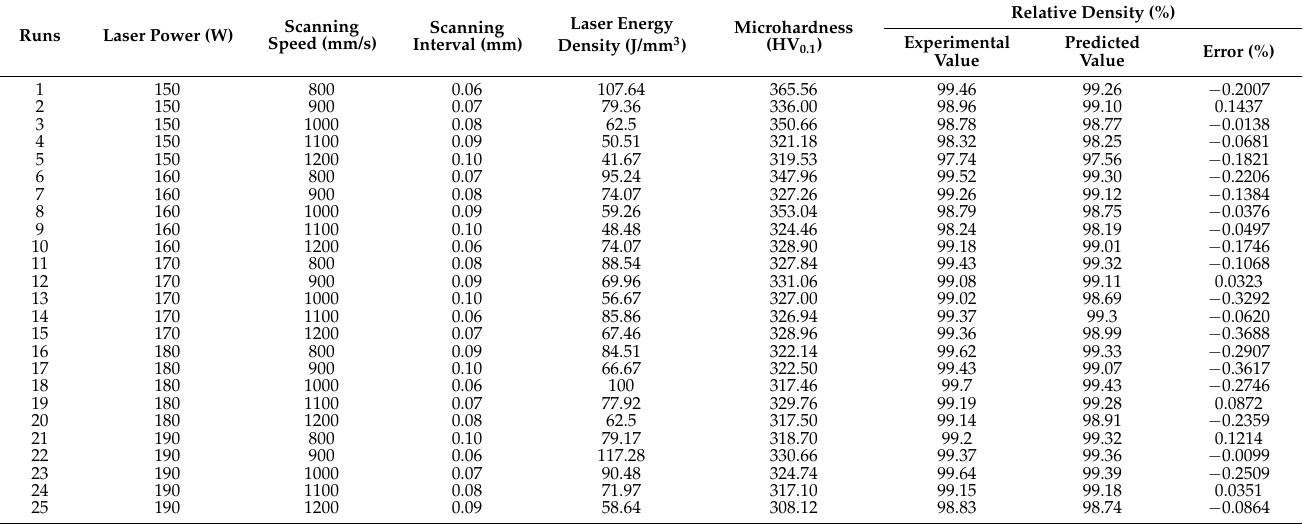
Table 3. Experimental design as L 25 orthogonal array and experimental results for relative